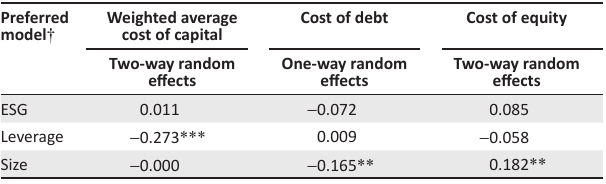
TABLE 1: Composite environmental, social and corporate governance disclosure regression results for sampled